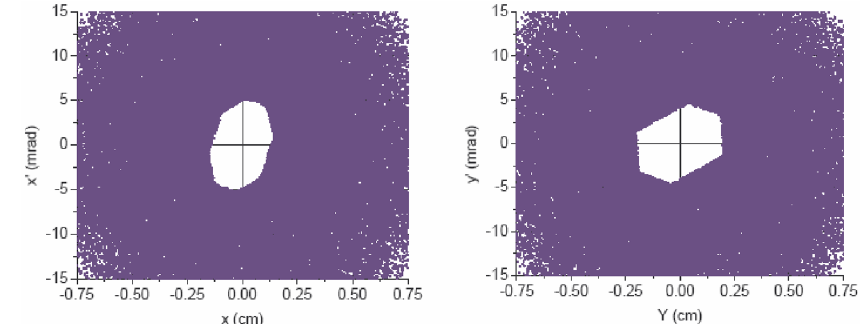
FIG. 8. (Color) Transverse acceptance of the MTS with collimators.